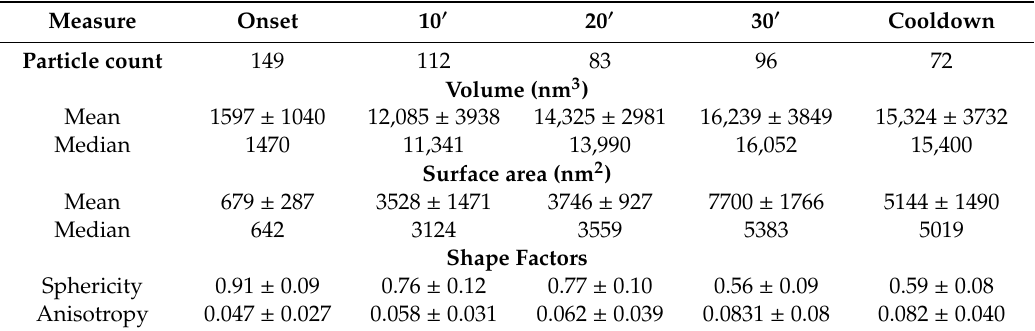
Table 1. Summary of the analysis of the tomographic 3D datasets. Means are provided as average ± standard